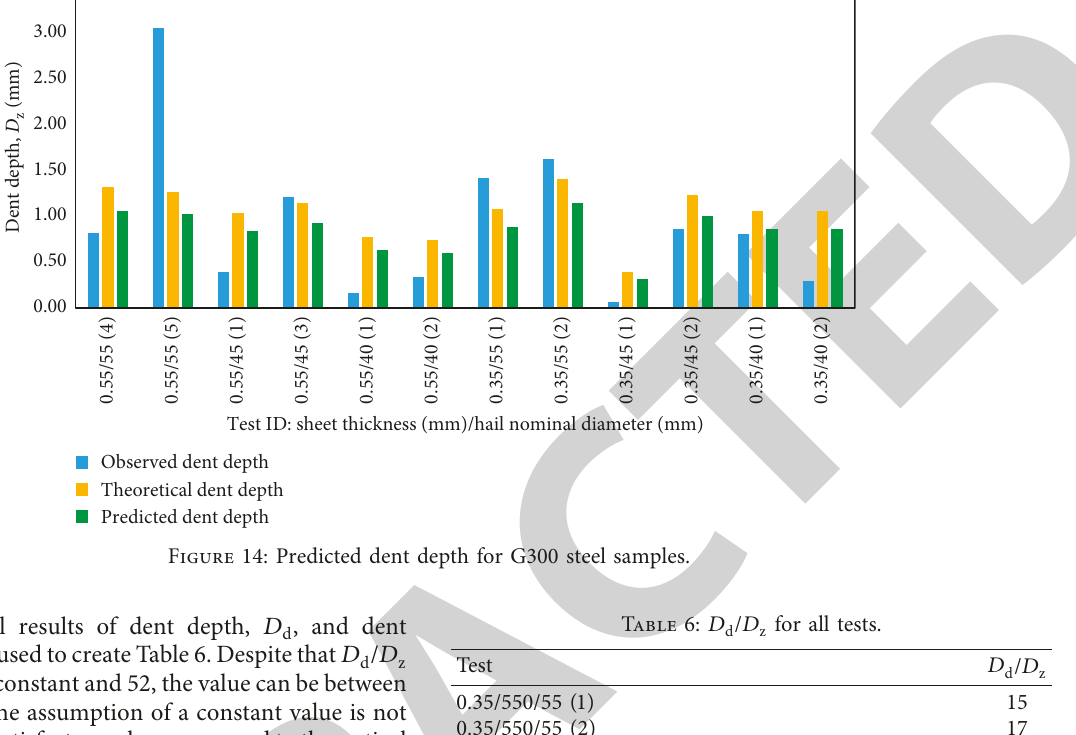
Table 6: D D d / z for all